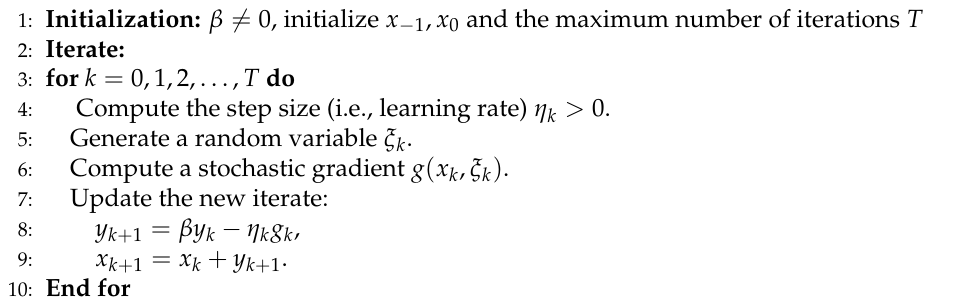
Algorithm 2 Adaptive Stochastic Gradient Descent Momentum (AdaSGDM)